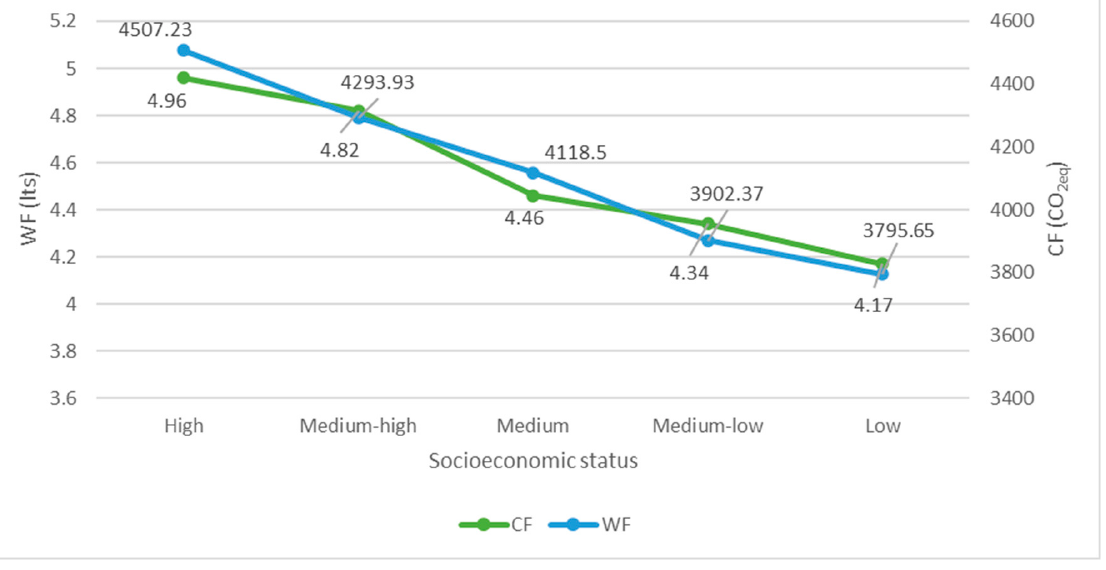
Figure 2. Carbon footprint (Kg CO 2 eq/day/person) and water footprint (L/day/person) of diet according to socioeconomic